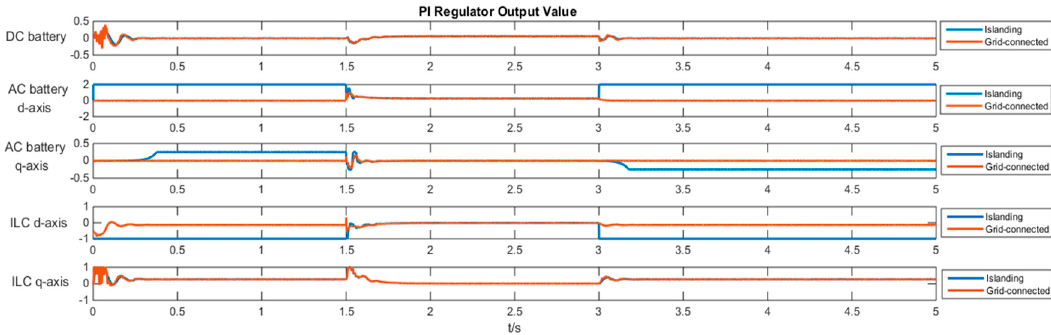
Figure 13. Regulation state of the direct transition control.